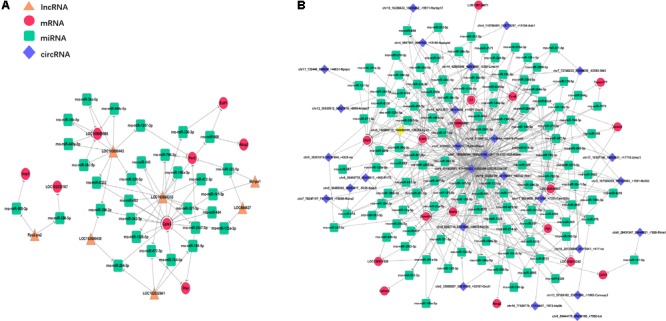
Interaction network of differentiated lncRNA–miRNA–mRNA and circRNA–miRNA–mRNA in the prefrontal cortex of Cont, MS, and MS+EA in adult rats. Diamond, round rectangle, ellipse, and triangle represent circRNA, miRNA, mRNA, and lncRNA, respectively. The genes shown in this figure are the same that belong to the increase-decrease type/decrease-increase type. (A) In the lncRNA–miRNA–mRNA predicted interaction network, 30 miRNAs are predicted to be possible target genes for regulating them. (B) In the circRNA–miRNA–mRNA predicted interaction network, 116 miRNAs are predicted.